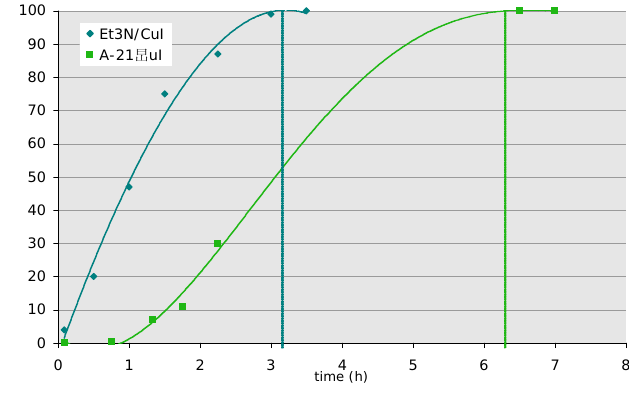
Figure 5. Kinetics for the formation of 3 in homo and heterogeneous